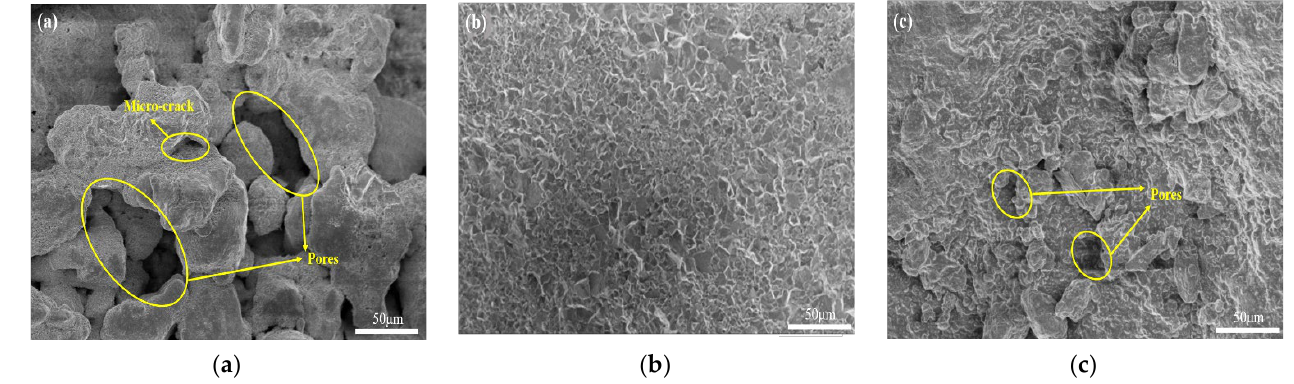
Figure 5. SEM images: ( a ) SSA magnified 400 times; ( b ) Natural limestone magnified 400 times; ( c ) PSSA magnified 400 times.